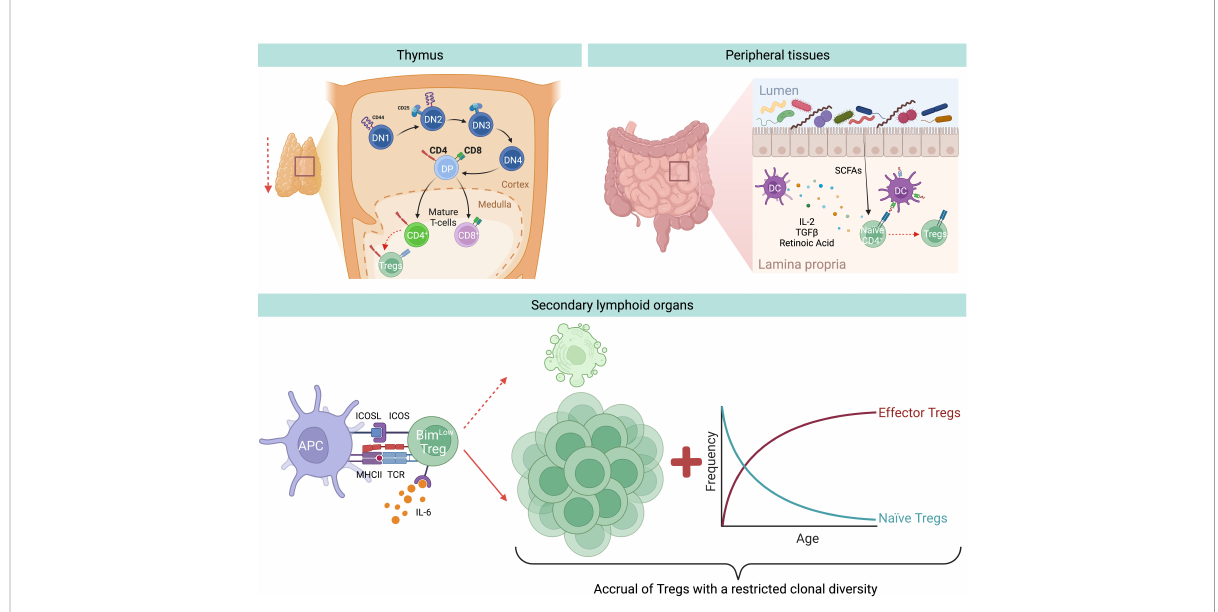
FIGURE 1 Aging-related changes of Treg generation and homeostasis. During aging there is a decreased generation of tTregs and pTregs. Thymic involution and reduced input of progenitor cells from the bone marrow result in a reduced output of recent thymic emigrants, among which are also less tTregs. In addition, in the peripheral tissues, for instance in the gut, there is a reduced induction of pTregs from naïve CD4 + T cells, likely due to age-associated changes in bacterial-derived metabolites, e.g. short chain fatty acids (SCFAs), or DC-derived Treg-inducing molecules, e.g. TGF- b or retinoic acid. Nevertheless, during aging there is an accumulation of Tregs in SLOs. This is mainly attritubed to the enhanced ability of old Tregs to escape apoptosis by selectively downregulating the expression of the pro-apoptotic protein Bim via the IL-6- ICOS-Bim axis. In addition, owing to the decreased production of naïve Tregs from the thymus, there is a resulting increase of effector Tregs in the